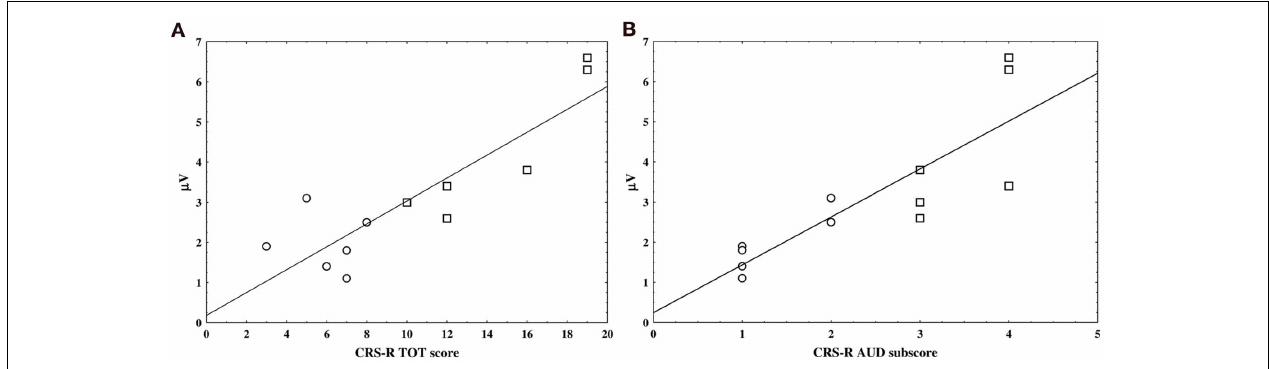
FIGURE 4 | The two scatter plots show the linear correlation between nP3 amplitude individual values in the active condition and the JFK CRS-R overall scores (panel A) and auditory sub-scores (panel B). VS and MCS patients are represented by circle and square,